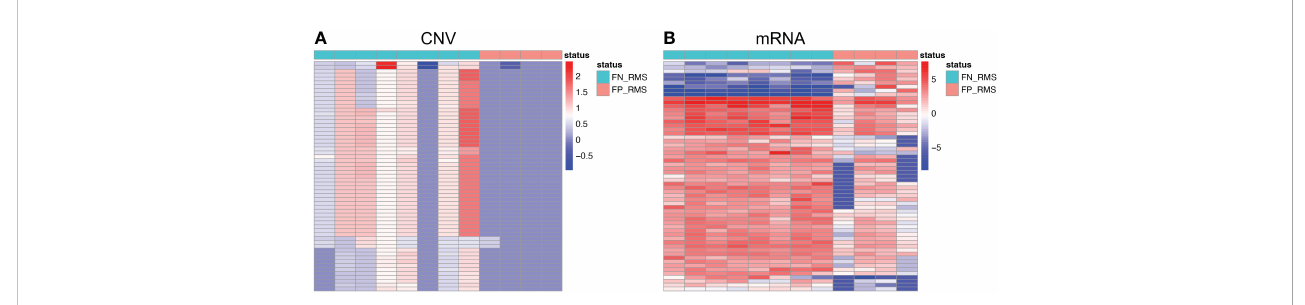
FIGURE 5 Heatmaps of Module 2 genes with consistent copy number and expression changes in FN-RMS vs FP-RMS in St. Jude dataset. (A) is for CNV; (B) is for